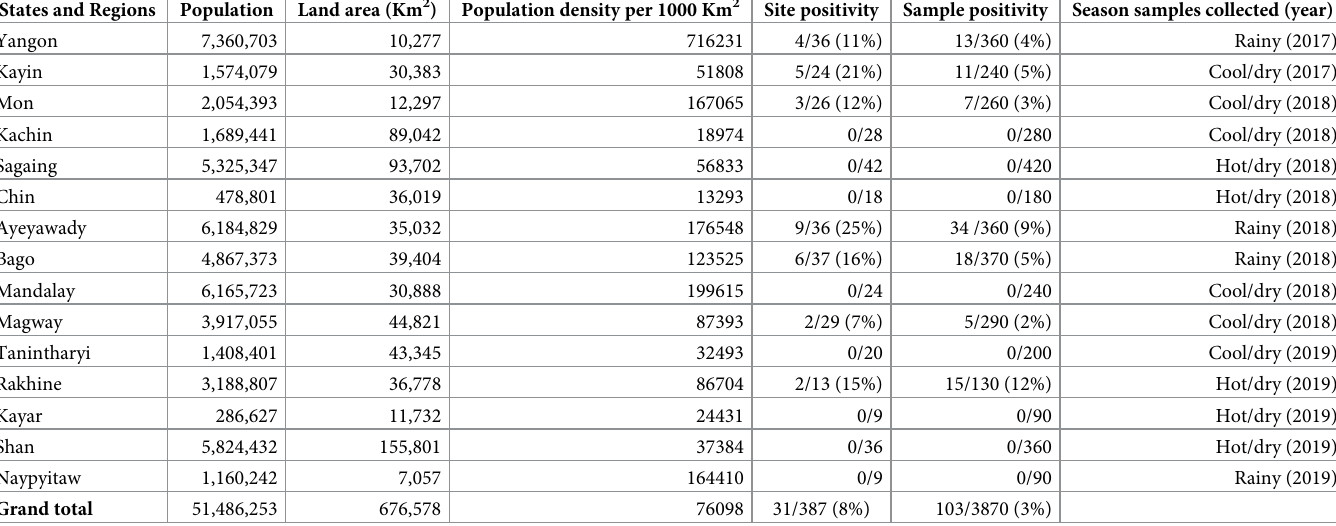
Table 1. Summary of population and land area together with number of sites and samples collected in each state and